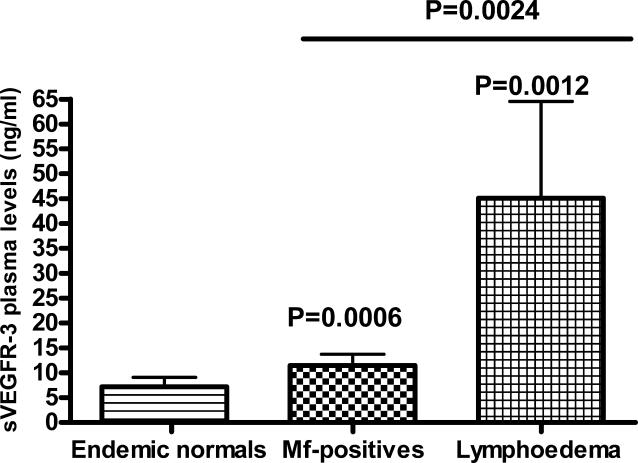
Pretreatment Plasma Levels of sVEGFR-3 in Filaria-Infected Patients and Endemic ControlsPlasma concentrations (mean ± SD) of sVEGFR-3 were measured using a commercial kit from plasma of lymphedema patients (n = 26), microfilaremic patients (n = 76), and endemic controls (n = 23, who did not have filarial infection). Mean plasma levels of sVEGFR-3 were significantly elevated in the microfilaremic (p = 0.0006) and lymphedema patients (p = 0.0012) compared to endemic controls (Student t-test with Bonferroni/Dunn correction). sVEGFR-3 was also significantly elevated in lymphedema patients (p = 0.0024) compared to microfilaremic patients.